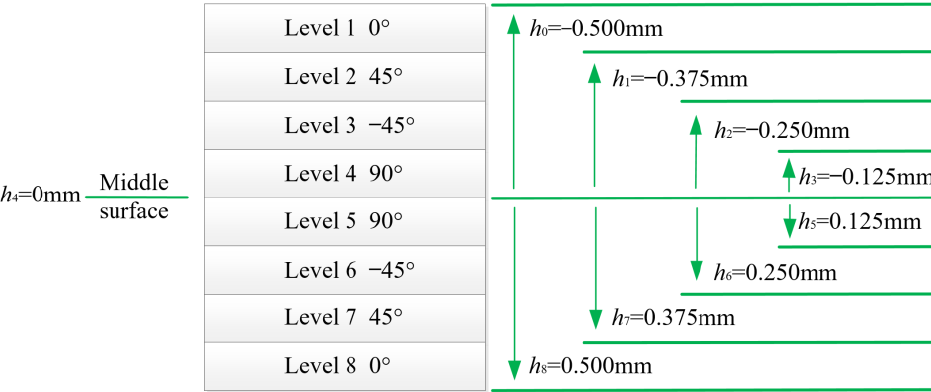
Figure 3. The thickness and angle of each single layer of